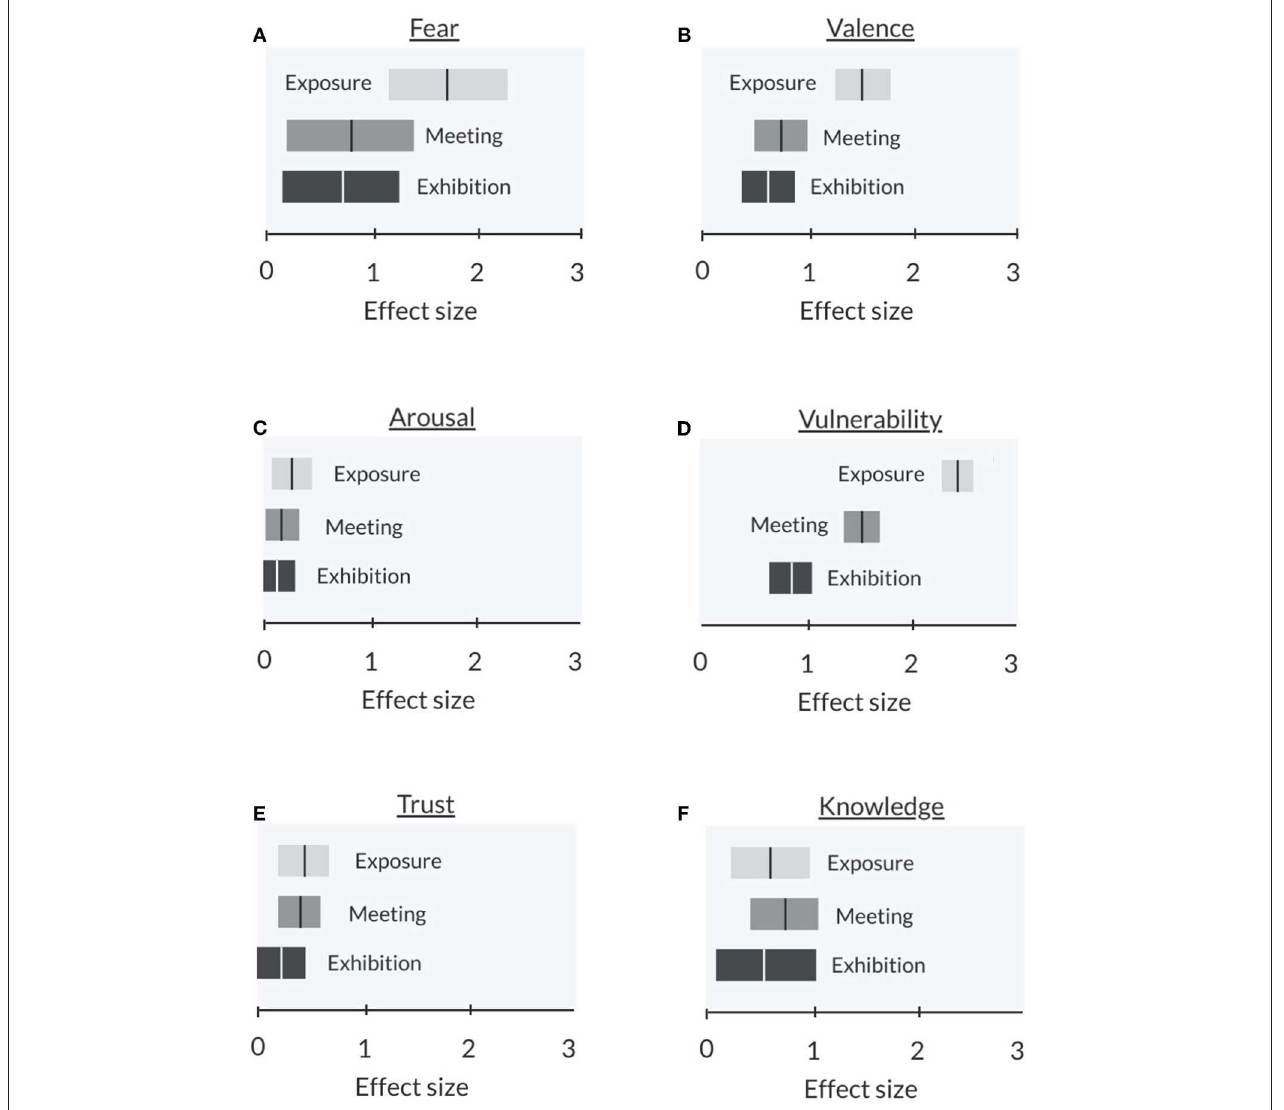
FIGURE 1 | The figure show the relations between the obtained effect sizes (marked with a line in the boxes) and their confidence intervals (shown by the length of the boxes) for the three interventions Guided walks with exposure, Information meeting, and Exhibition for the six dependent variables; Fear (A) , Valence (B) , Arousal (C) , Vulnerability (D) , Trust (E) , and Knowledge (F)